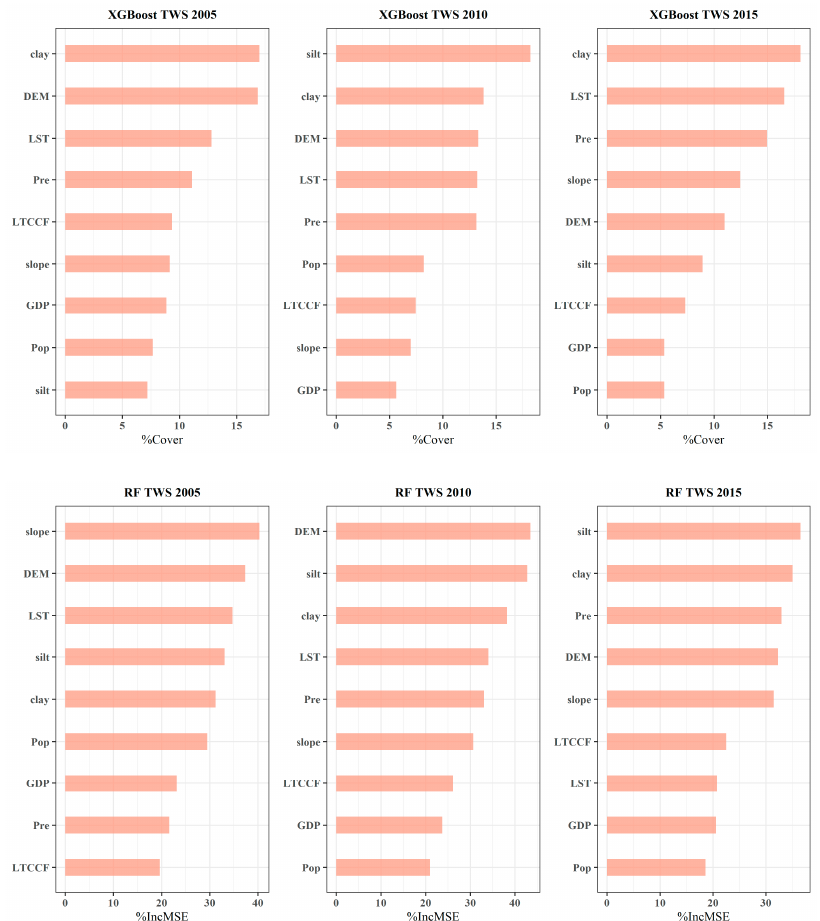
Figure 5. Plots of the variable importance measure (increase in the mean square error (%IncMSE)) for the RF-modeled TWS and Cover metric of the number of observation related to this feature (%Cover) for the XGBoost-modeled TWS for 2005, 2010 and 2015 based on CSR-SH data.